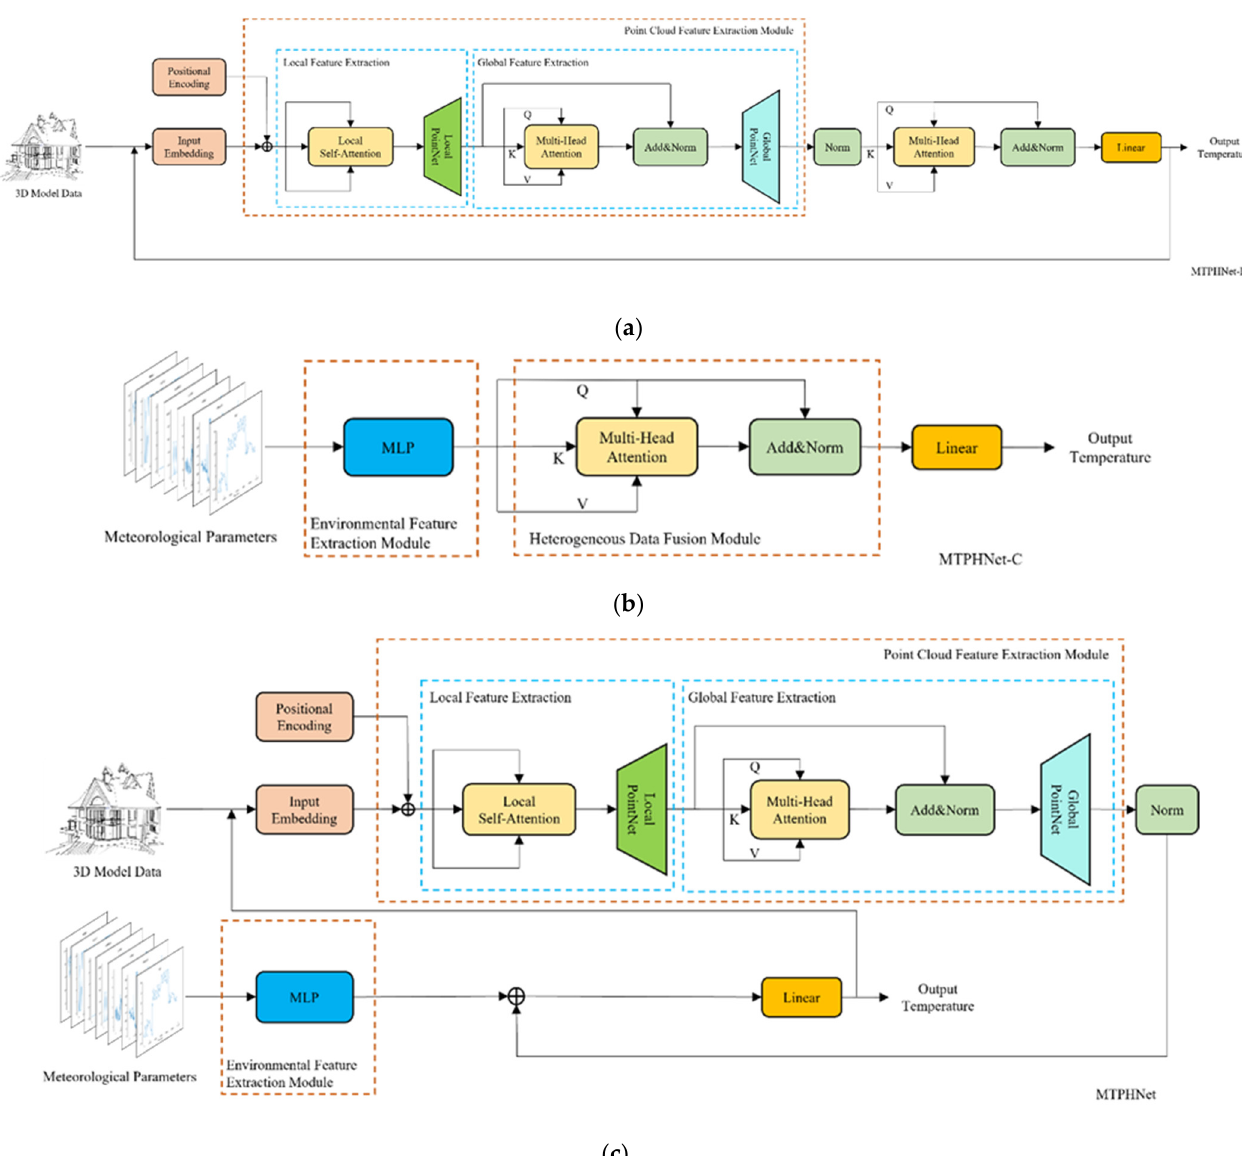
Figure 14. Multivariate temperature field prediction network based on heterogeneous data (MTPHNet) variants for ablation experiments: ( a ) MTPHNet-B removes the environmental data feature mapping module (EMM) to study the effect of meteorological parameters on temperature field prediction; ( b ) MTPHNet-C removes the point cloud feature extraction module (PCEM) to study the effect of thermophysical parameters on temperature field prediction; and ( c ) MTPHNet-D replaces the data fusion module (DFM) with an additive fusion method to study the effect of data fusion on temperature field prediction.